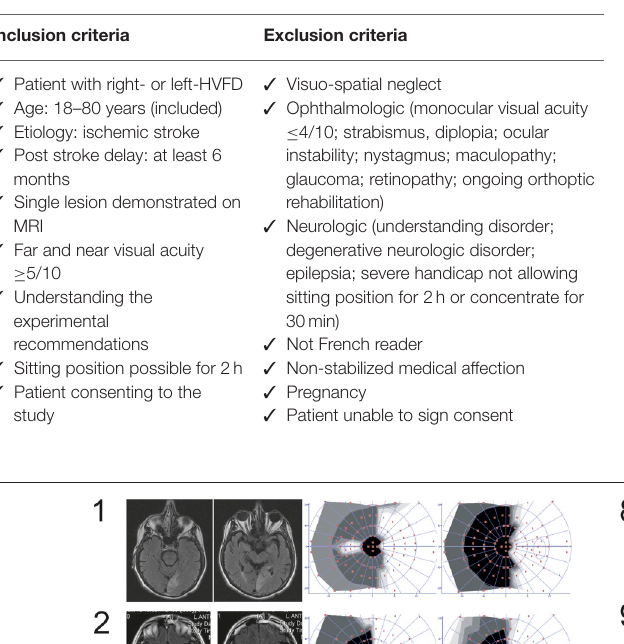
Frontiers in Behavioral Neuroscience |